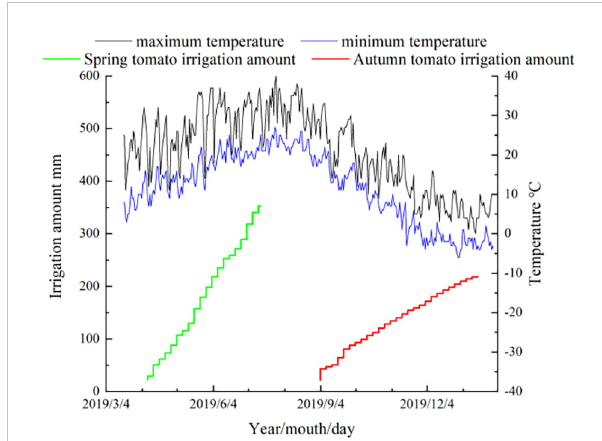
FIGURE 2 Meteorological data and irrigation record of tomato growth period. Diameter of micropore is d=0.8mm; The internal spacing of the micropores group was I =0.4cm; The Angle of micropores is =68°; The micropore group spacing is L.